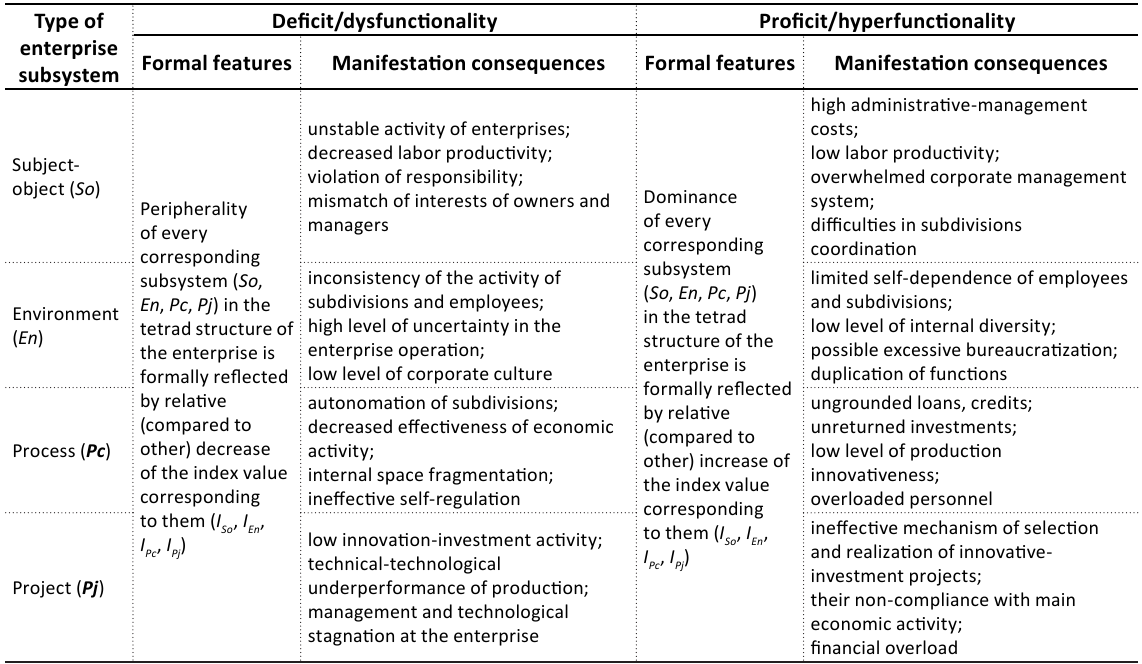
Table 5. Characteristic of features and functional consequences of structural violations, caused by relative deficit or proficit of certain subsystems in the enterprise structure Source: Developed by the author based on Kleiner